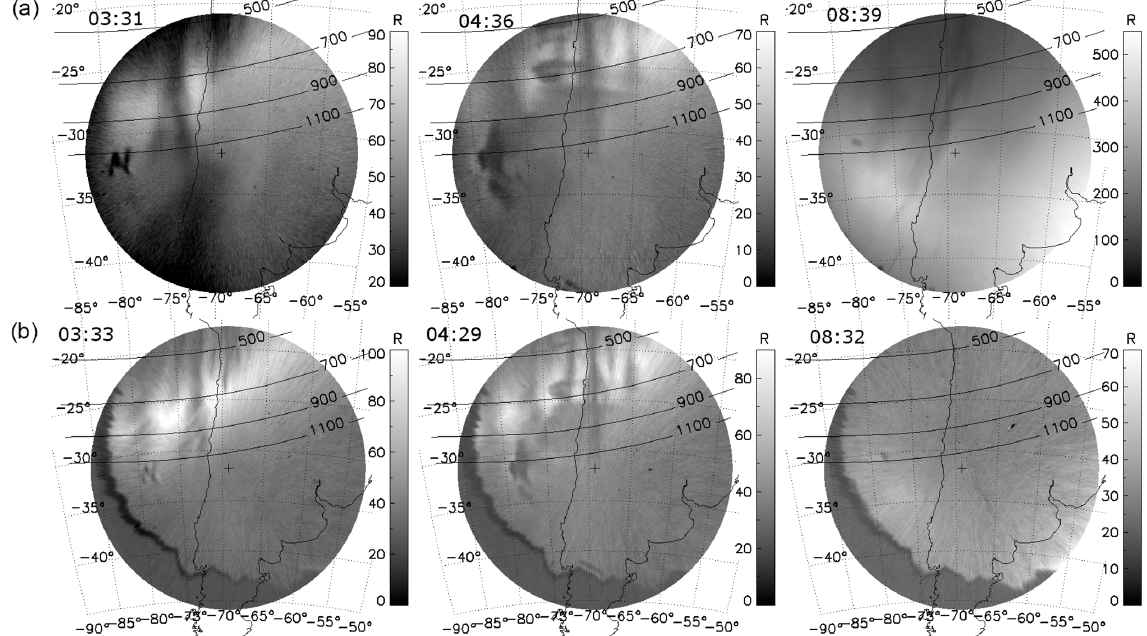
Figure 8. Unwarped images from the El Leoncito ASI on 29 October 2014. Row (a) shows 6300Å images and row (b) shows corresponding 7774Å images. Dotted lines represent geographic latitude and longitude. The plus sign in the middle is the location of the ASI. The map shows the coasts of South America. Lines of constant magnetic apex altitude are shown from 500 to 1100km. Depletions are visible extending from the north to zenith. The bright band visible in the north in the earlier images is the crest of the equatorial ionization anomaly. At 08:39UT the 6300Å emission is much greater due to the presence of a